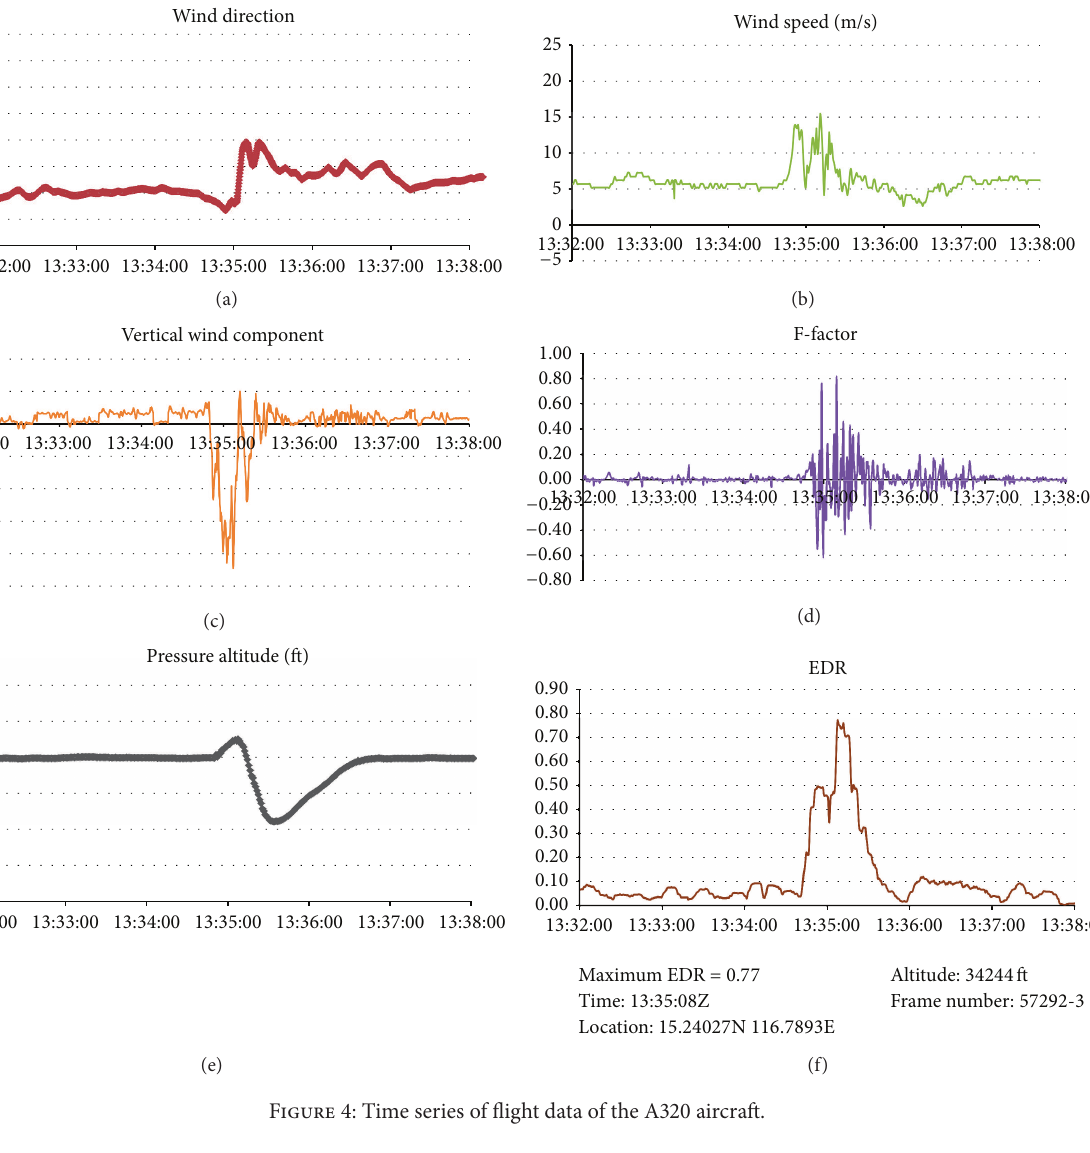
Figure 4: Time series of flight data of the A320